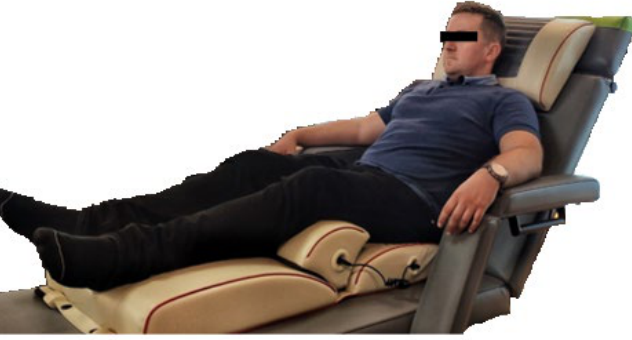
Figure 2. The position of the body on the device generating the vibration stimulus (illustrative photo) .